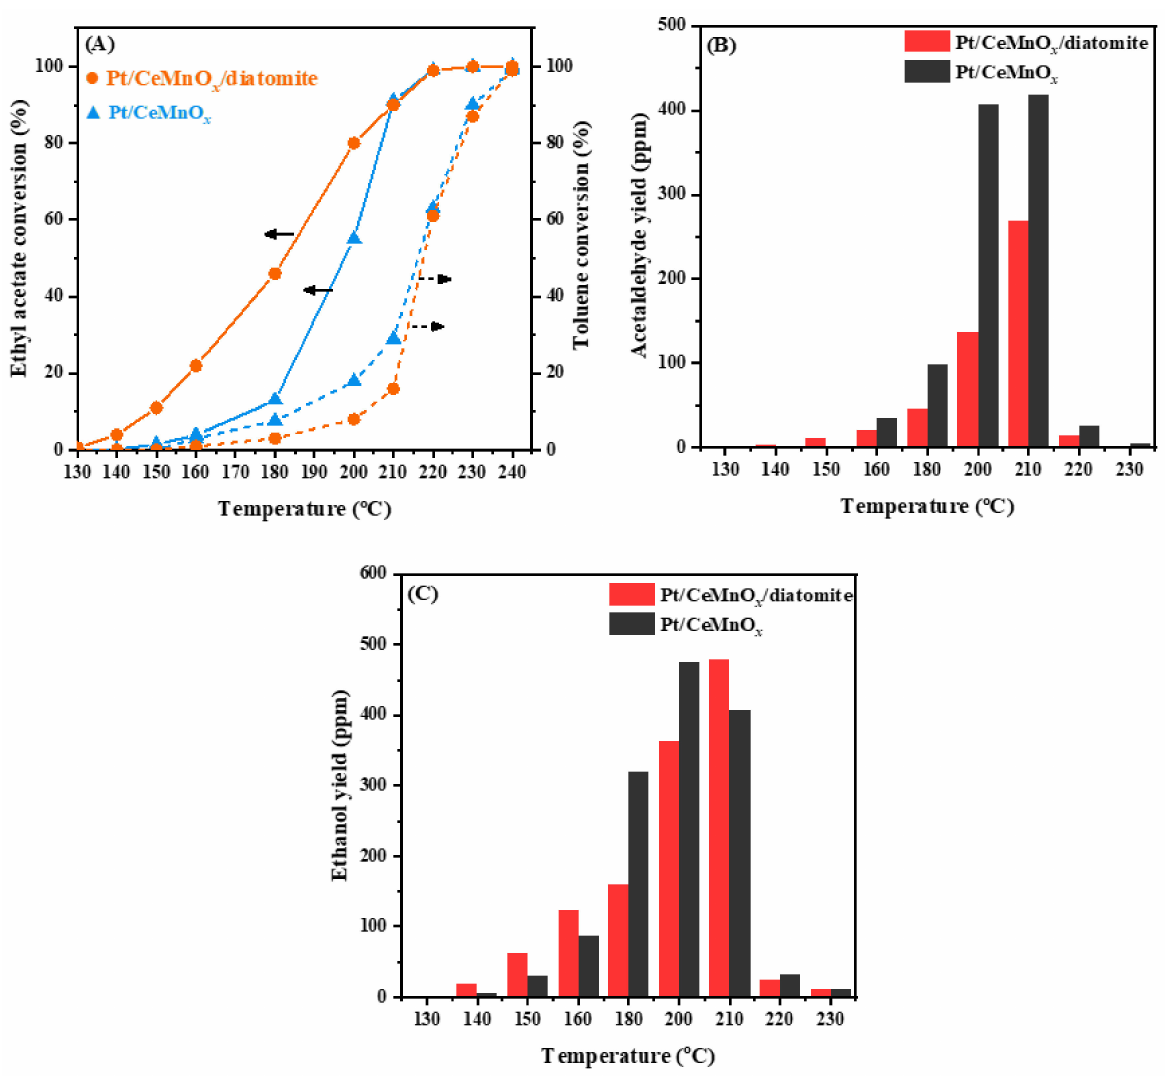
Figure 8. ( A ) Ethyl acetate or toluene conversion, ( B ) acetaldehyde yield, and ( C ) ethanol yield as a function of reaction temperature over the Pt/CeMnO x and Pt/CeMnO x /diatomite samples.